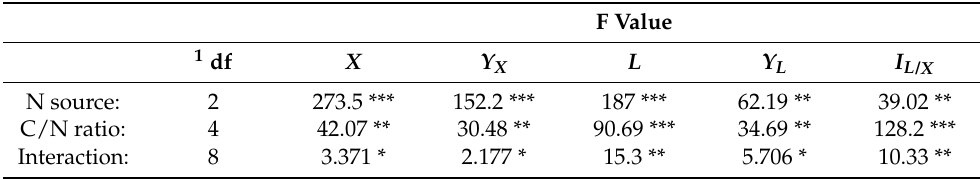
Table 7. Two-way ANOVA of factors affecting performance of L. tetrasporus DSM 70314, grown on wheat straw hydrolysate with different nitrogen sources and C/N ratios.